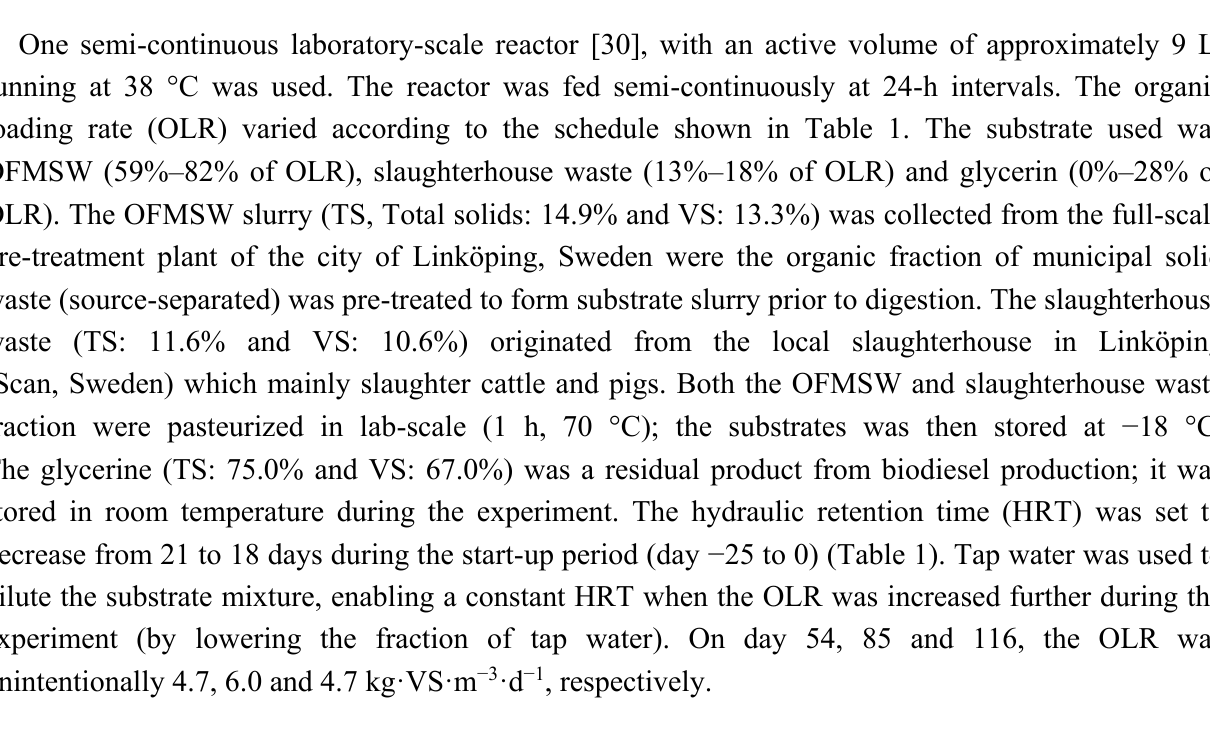
Table 1. Schedule of changes to organic loading rate (slaughterhouse waste, the organic fraction of municipal solid waste (OFMSW) and glycerin) and hydraulic retention time (HRT) in the semi-continuously fed anaerobic digester during the experimental